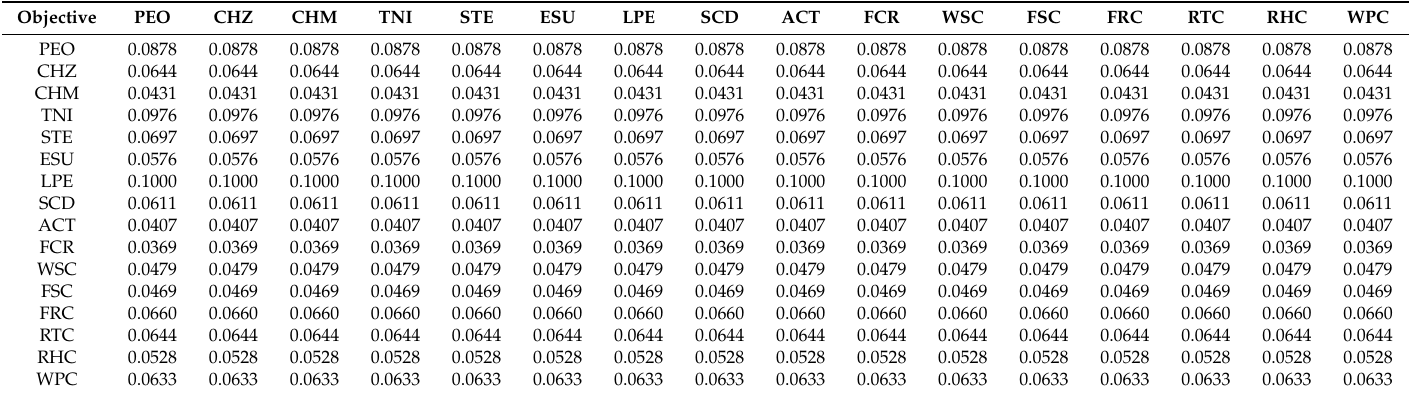
Table 6. Unweighted supermatrix for temporary facility layout plan